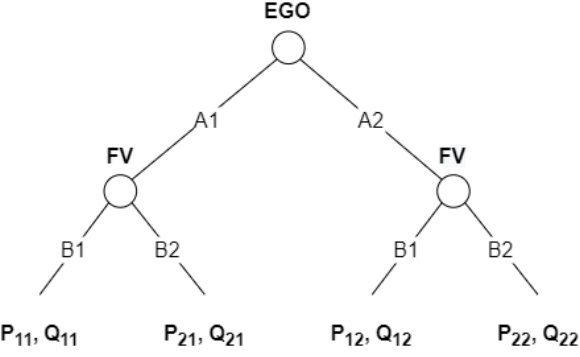
Figure 2. Dynamic noncooperative game description in its extensive-form representation. EGO and FV denote the players; A 1 and A 2, and B 1 and B 2 denote their respective sets of strategies. Pxy and Qxy denote the outcome of the game, where x is the FV’s selected strategy and y is the strategy selected by